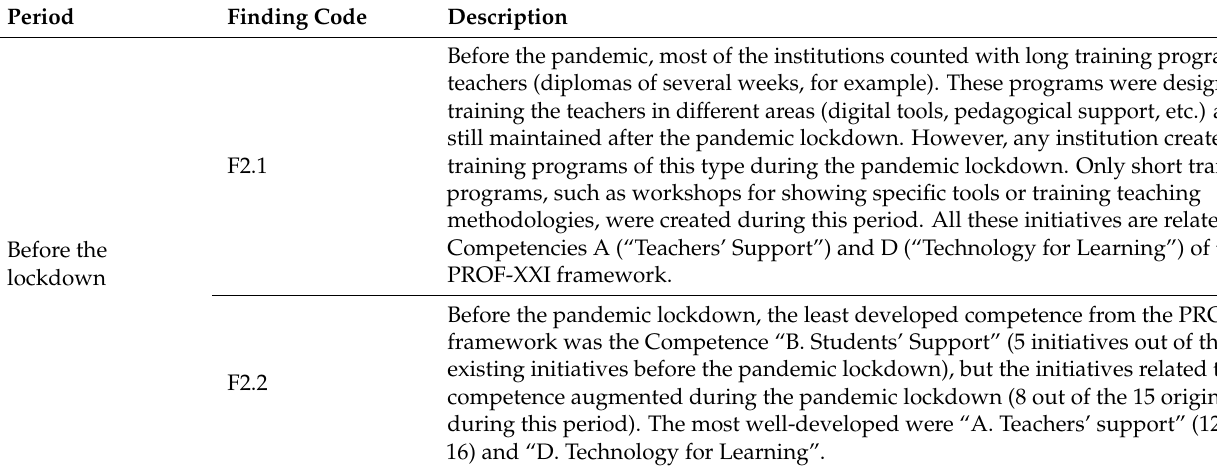
Table 4. Findings from RQ2. Findings for RQ2 obtained from the analysis of [Pre&Post